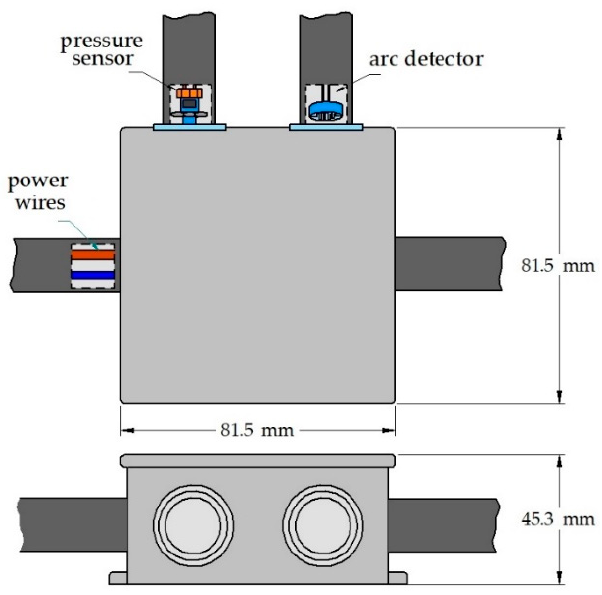
Figure 1. Electrical installation box which is a housing for an arc fault source.